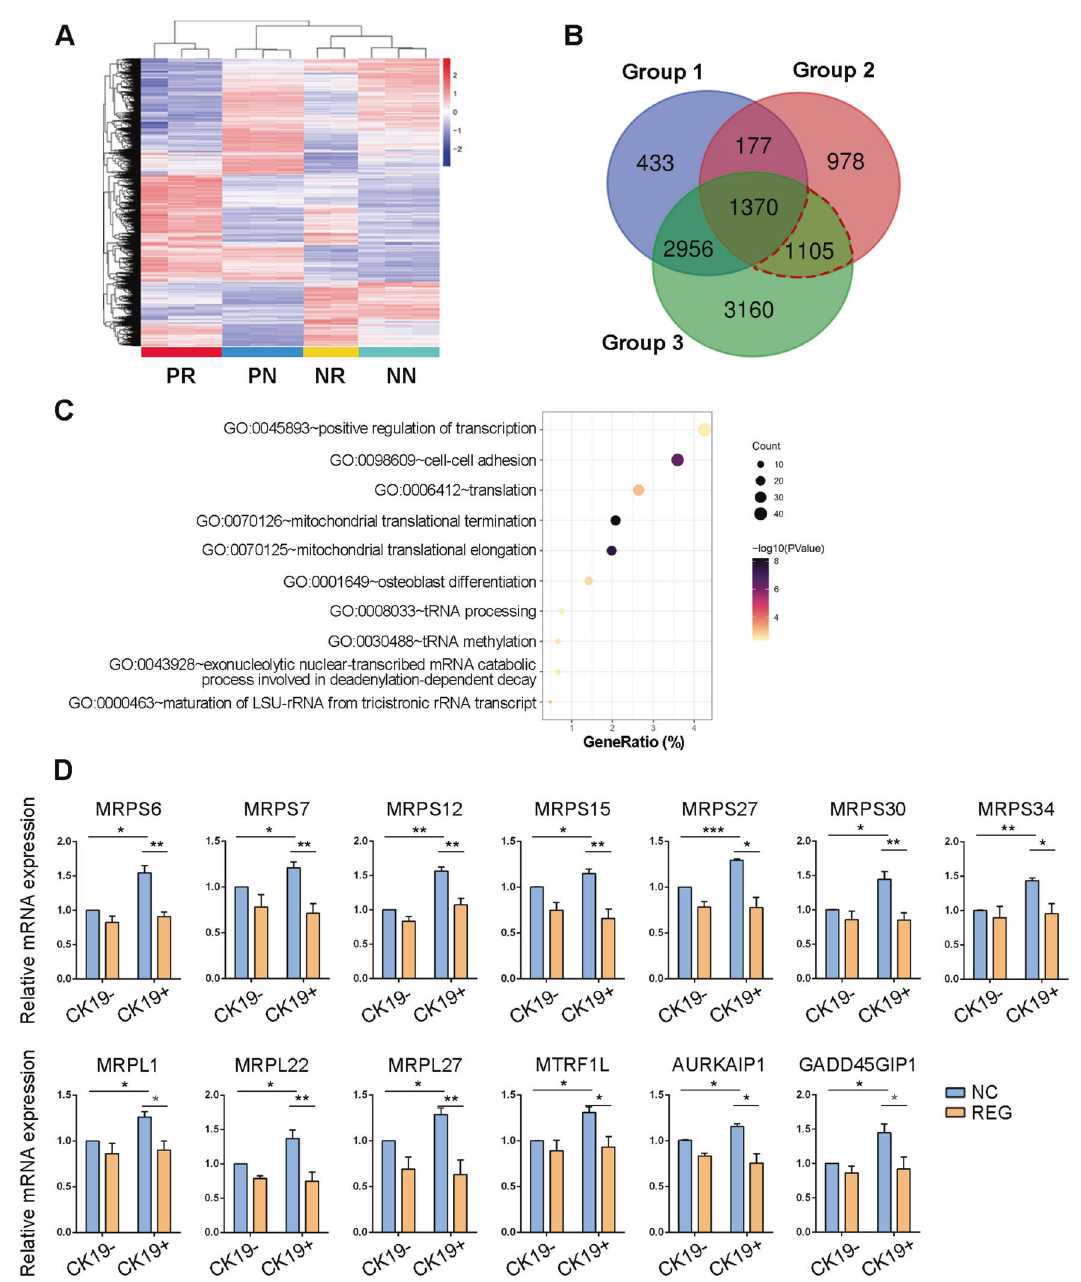
Fig. 5 Mitochondria was involved in mediating the sensitivity of CK19 + cells to regorafenib. A Heatmap of DEGs in the four groups. PR, CK19-positive cells treated with regorafenib; PN, CK19-positive cells as a negative control; NR, CK19-negative cells treated with regorafenib; NN, CK19-negative cells as a negative control. B Venn diagram of three groups of DEGs. Group 1, DEGs between NR and NN; group 2, upregulated genes from DEGs between PN and NN; group 3, regulated genes from DEGs between PR and PN. C Top 10 enriched biological processes by GO analysis. D Relative mRNA expression of mitochondrial ribosomal proteins (MRPs) in CK19 − and CK19 + cells treated with control and regorafenib. The data are shown as mean ± SD. * P < 0.05, ** P < 0.01, and *** P < 0.001. NC, negative control; REG, regorafenib; CK19 − , CK19-negative; CK19 + , CK19-positive; DEGs, differentially expressed